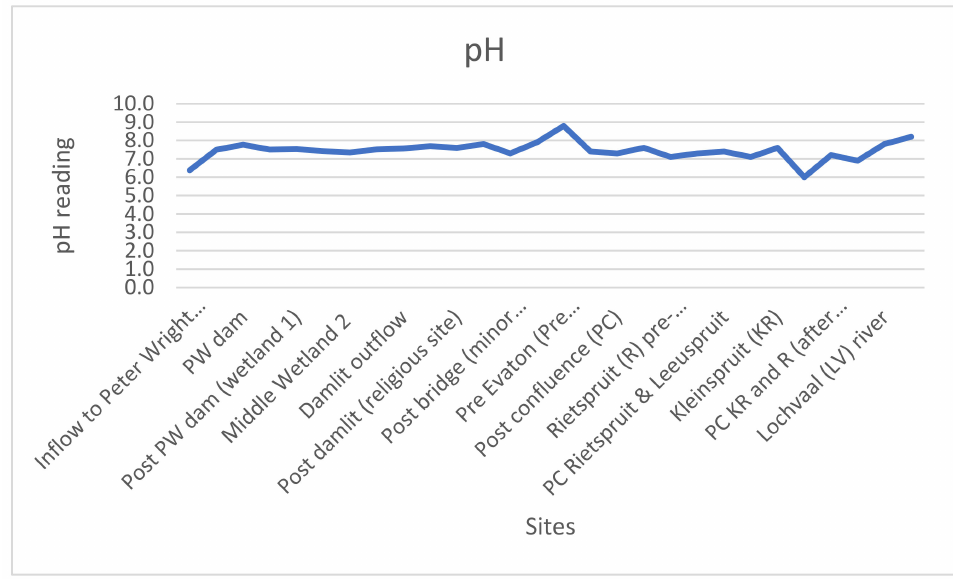
Figure 2. pH readings at the sampled